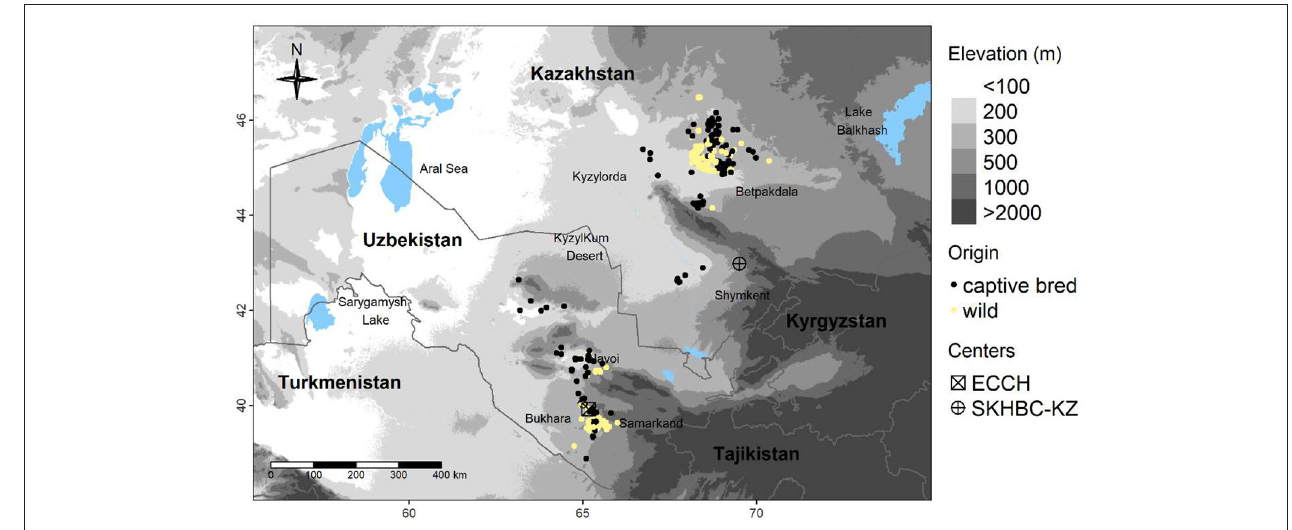
FIGURE 1 | Nests locations in our study areas in central Kazakhstan and Uzbekistan between 2013 and 2018 from wild-born ( n = 316) and captive-bred ( n = 203) migrant Asian houbara ( Chlamydotis macqueenii ).